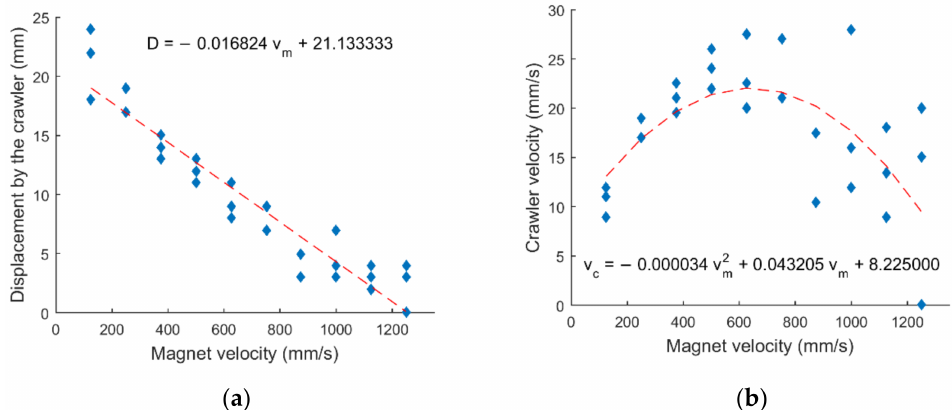
Figure 8. Scatter plot of ( a ) the displacement D by the MAE crawler in one cycle against the average velocity v m of the magnet, and ( b ) crawler velocity v c against the average velocity of the magnet in horizontal pipe in the case of peristaltic locomotion. Due to repeated data points, there are less than 3 observable data points for certain